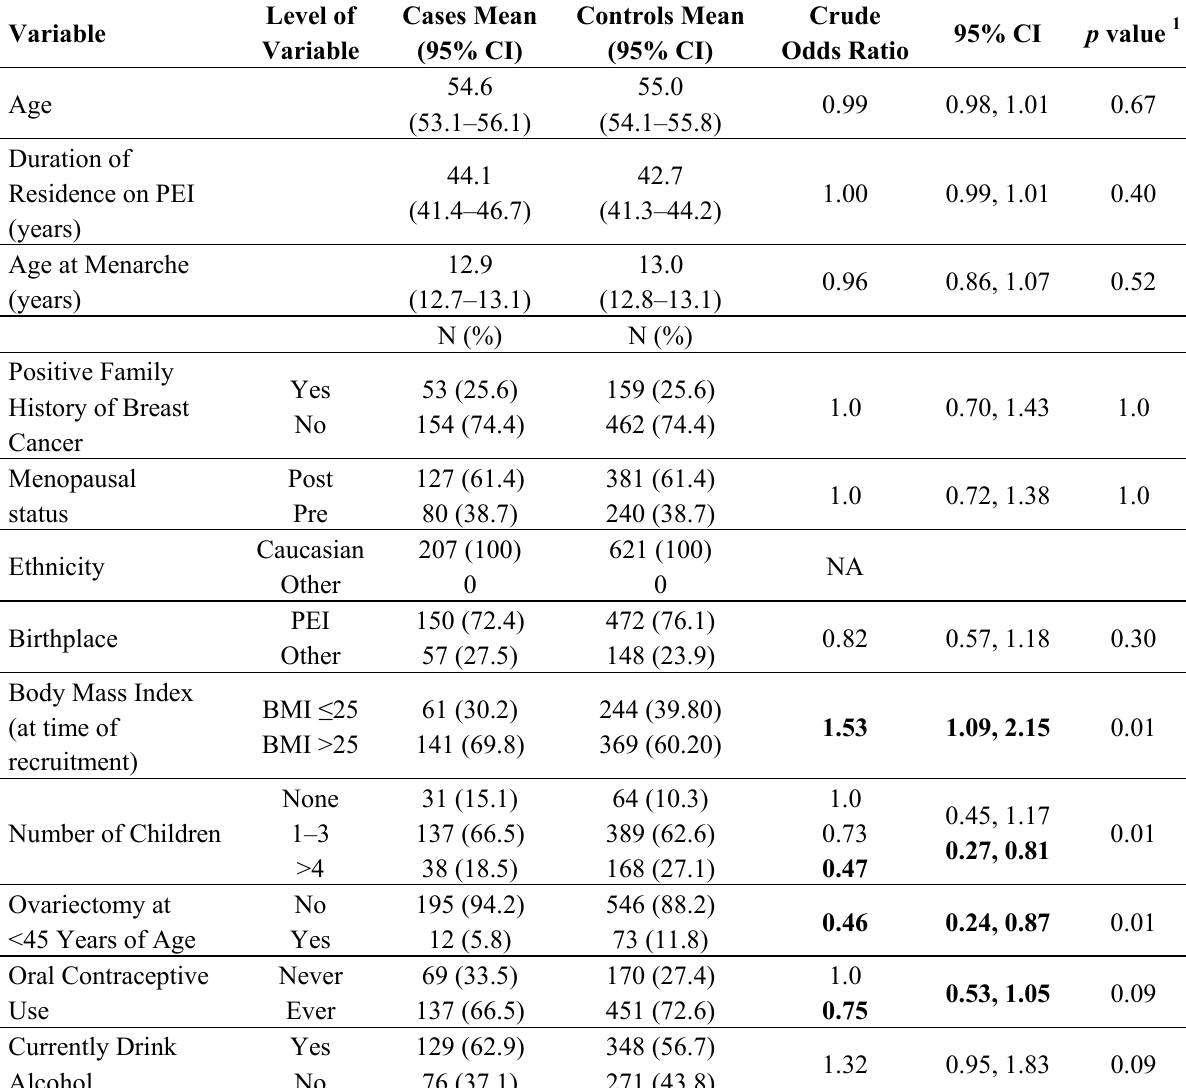
Table 1. Univariate analysis of association between sociodemographic and lifestyle covariates and breast cancer risk, PEI,